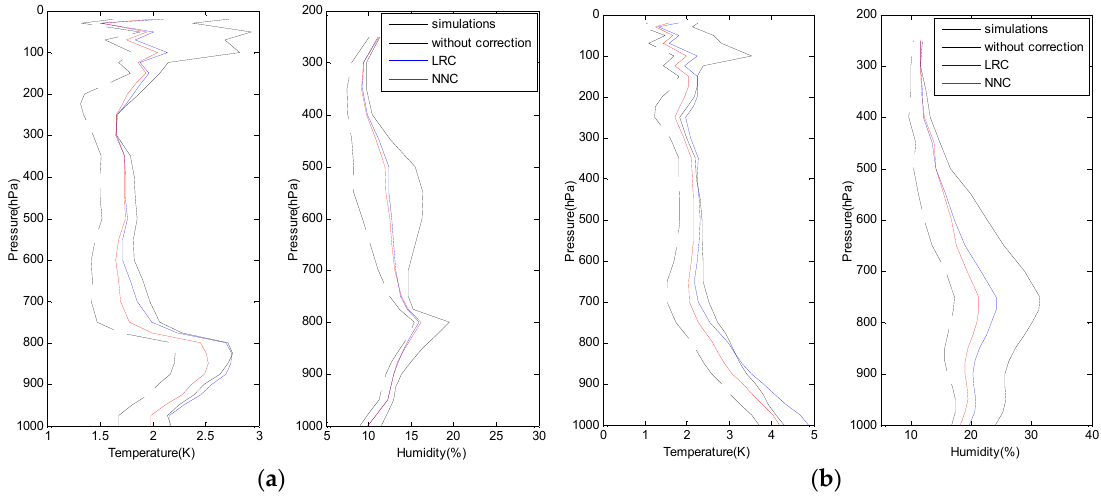
Figure 8. Temperature and relative humidity RMSE of retrieval over: ( a ) ocean; ( b ) land.